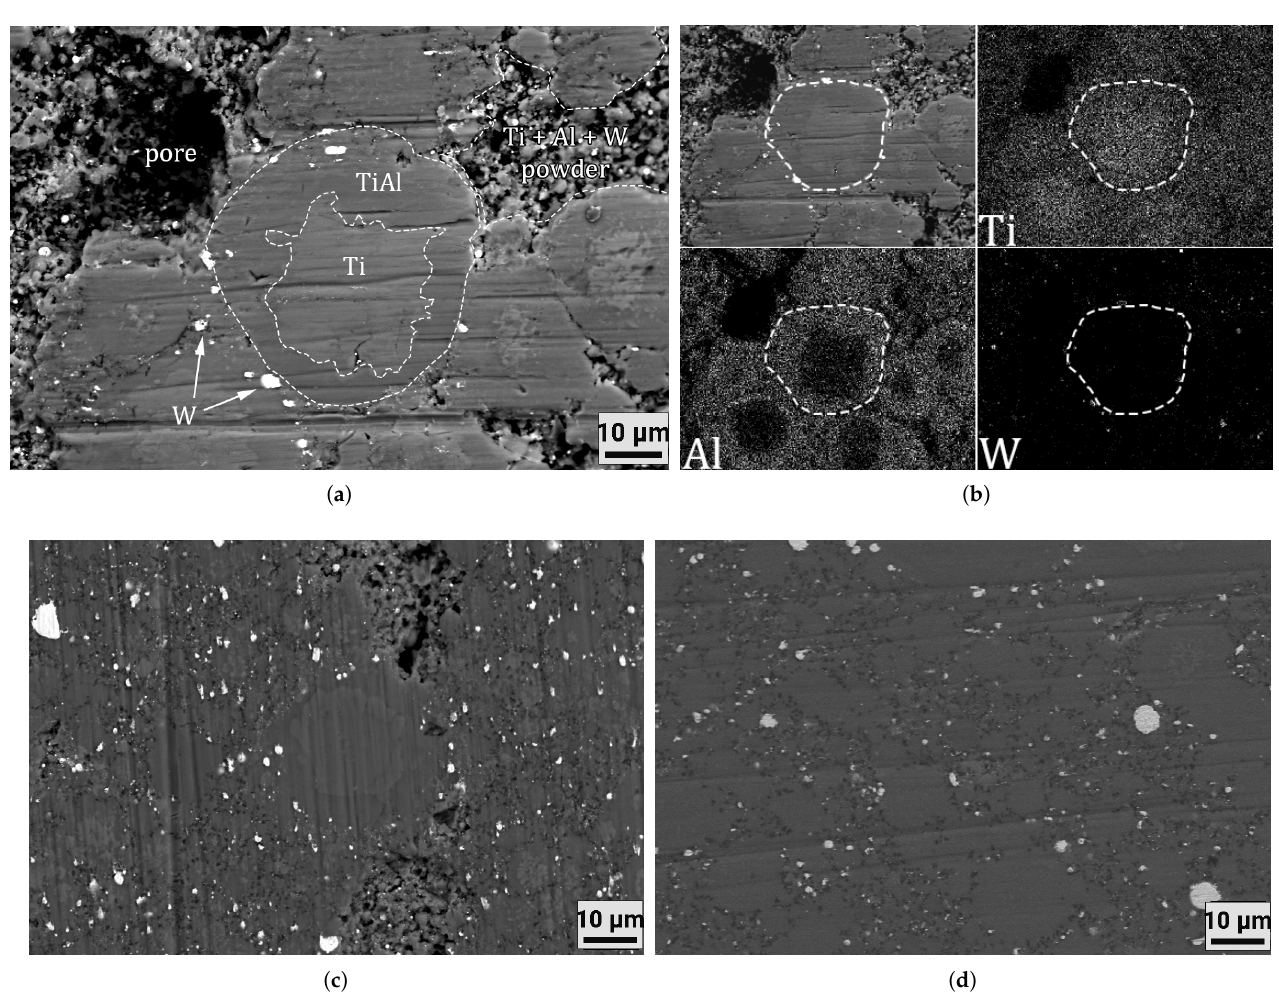
Figure 2. Microstructure of the TAW1 ( a ), TAW2 ( c ), TAW3 ( d ) samples in a cross-section after HIP and EDX spectra of the TAW1 ( b